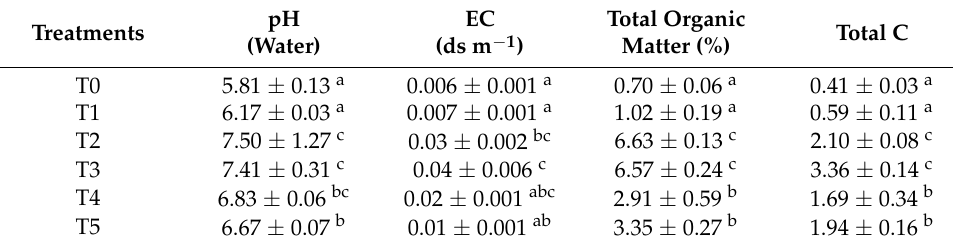
Table 7. Effects of RSRH biochar on soil pH, EC, total organic matter, and total C at harvest (70 DAT). Treatments